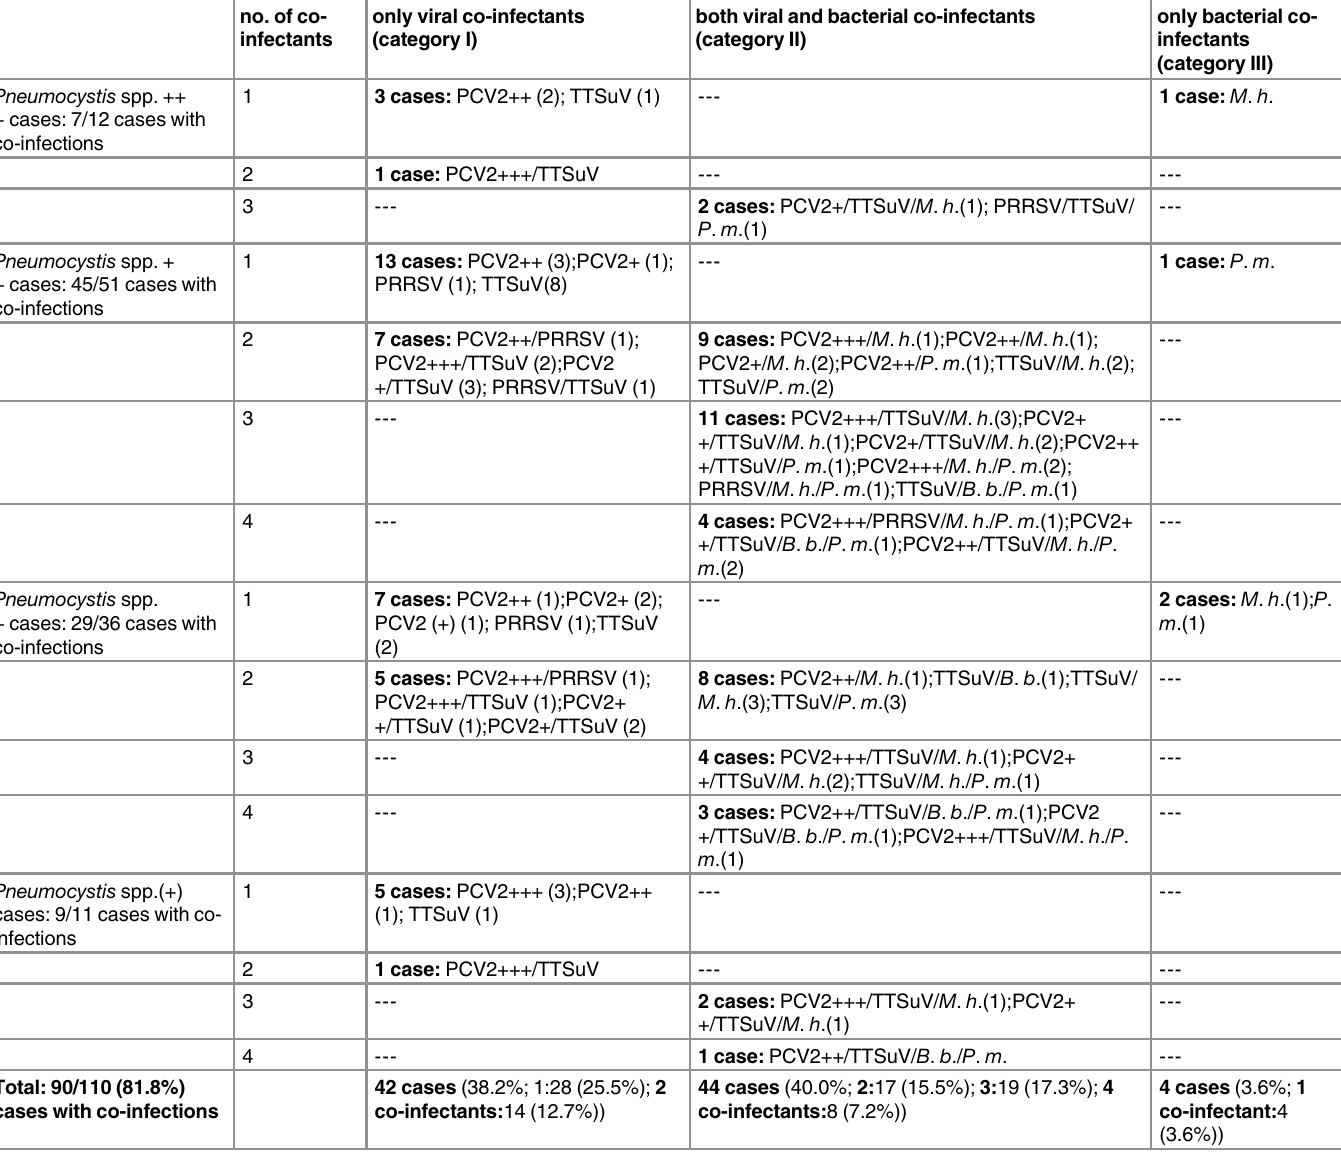
both viral and bacterial co-infectants (category II)